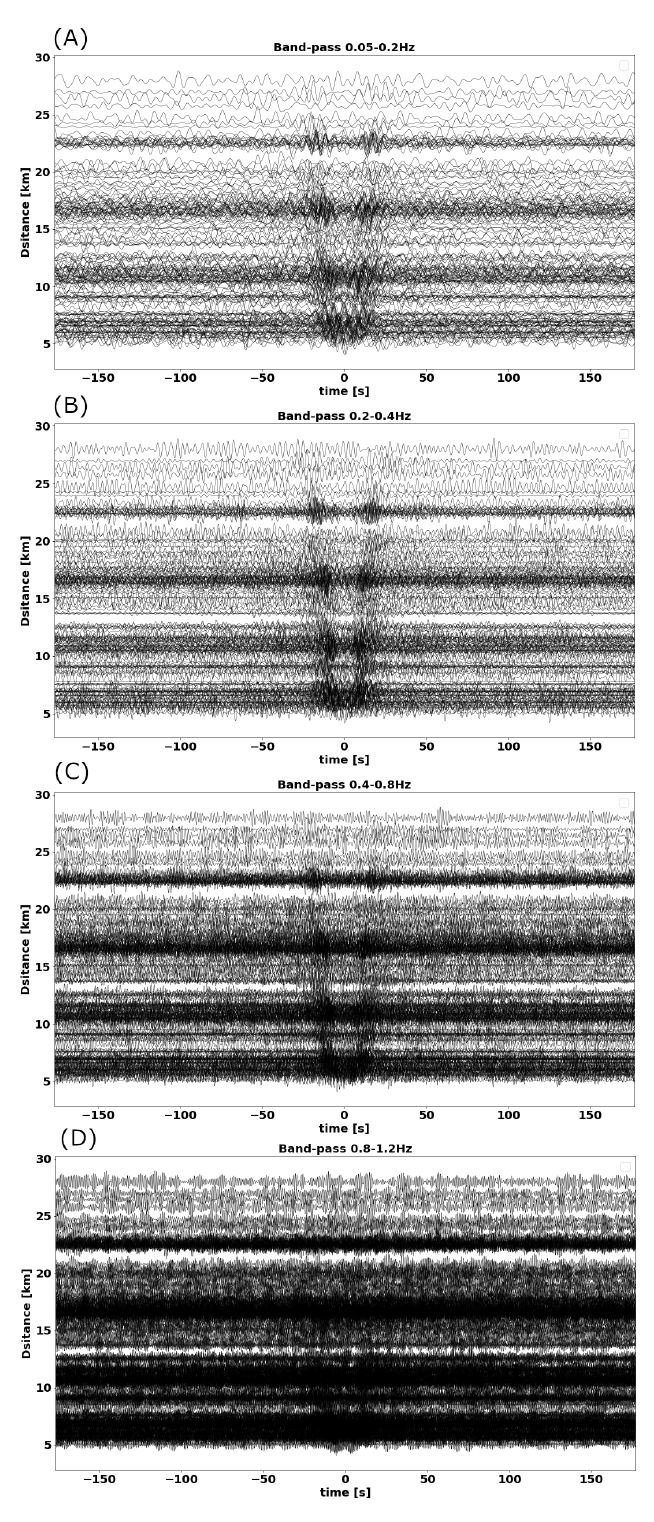
Figure 3. Cross-correlation in time domain for all the station pairs with inter-station distance between 5 and 28 km and for four frequency bands ( A ) 0.05–0.2 Hz, ( B ) 0.2–0.4 Hz, ( C ) 0.4–0.8 Hz, and ( D ) 0.8–1.2 Hz. The symmetry in positive and negative lags show the ambient-noise sources were homogeneously distributed. This symmetry is best observable for frequencies less than 0.8